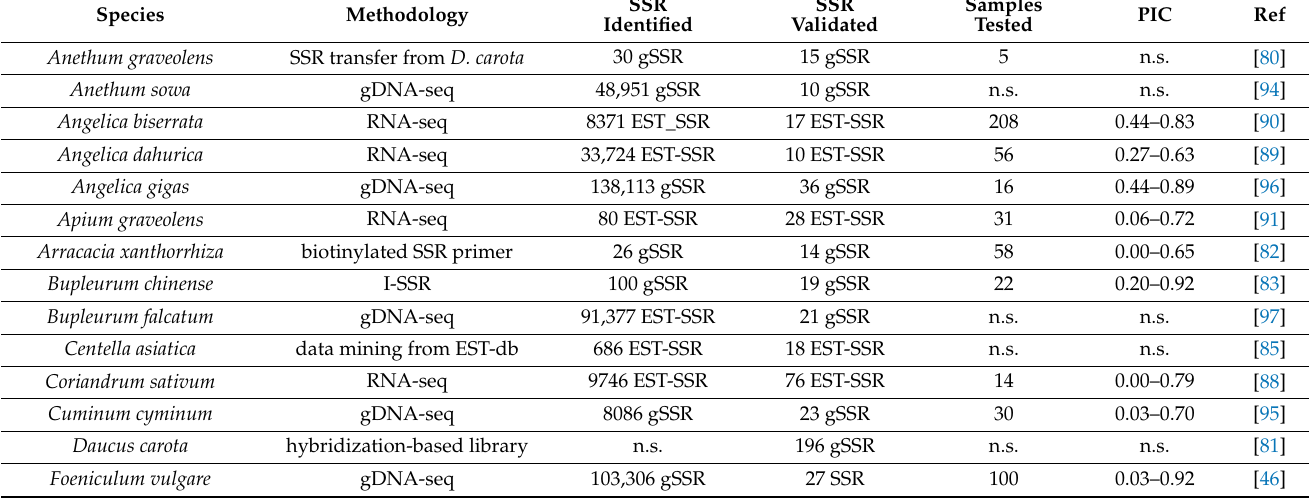
Table 2. SSR (genomic SSR, gSSR or expressed sequence tag-derived SSR, EST-SSR) marker sets available for Apiaceae species along with the methodology employed for microsatellite identification and, when available (n.s. = not specified), the number of samples used for validation and the resulting Polymorphism Information Content (PIC)